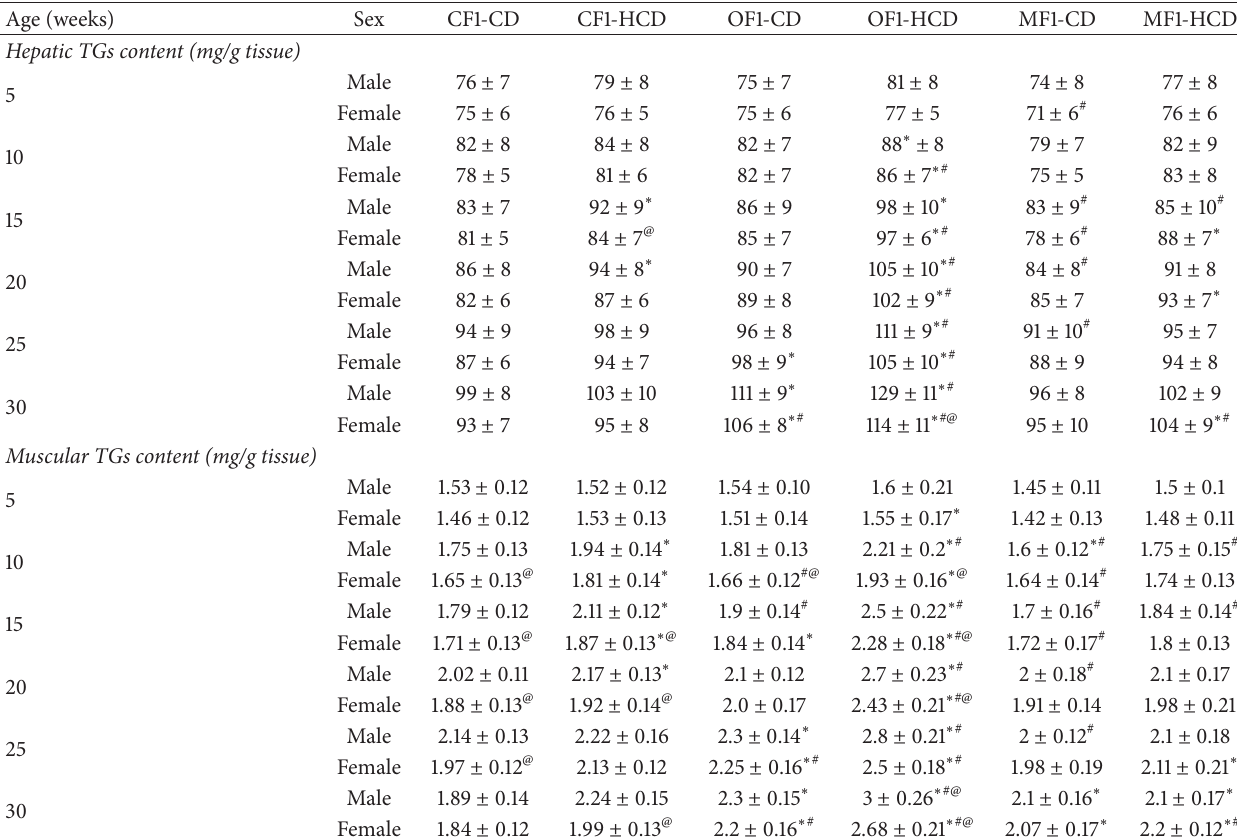
Table 1: Hepatic and muscular content of TGs (mg/g tissue) in different study